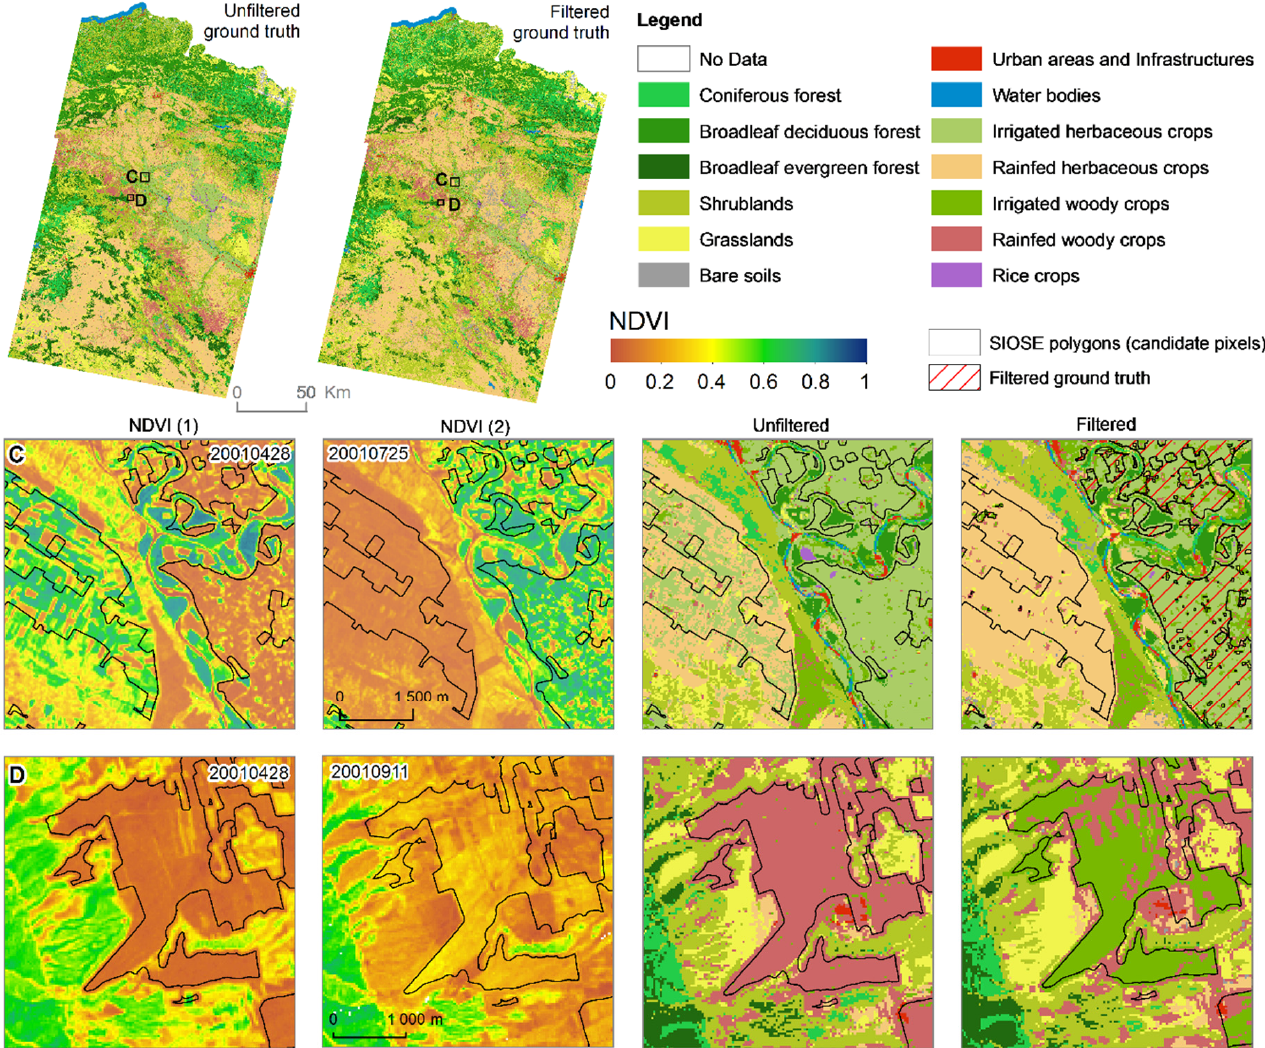
Figure 17. Examples of the application of filtering rules. In ( C ), irrigated and dry herbaceous crop patterns coexist within irrigated herbaceous crop polygons (outlined in black). Unfiltered TTA misclassified dry patterns as irrigated crops, while filtered TTA correctly discriminated between categories. In ( D ), an irregular, high NDVI activity is located in dry vineyard woody crop polygons (in black). Unfiltered TTA misclassified the crop fields as dry woody crops, while the filtered TTA correctly classified them as irrigated woody crops.